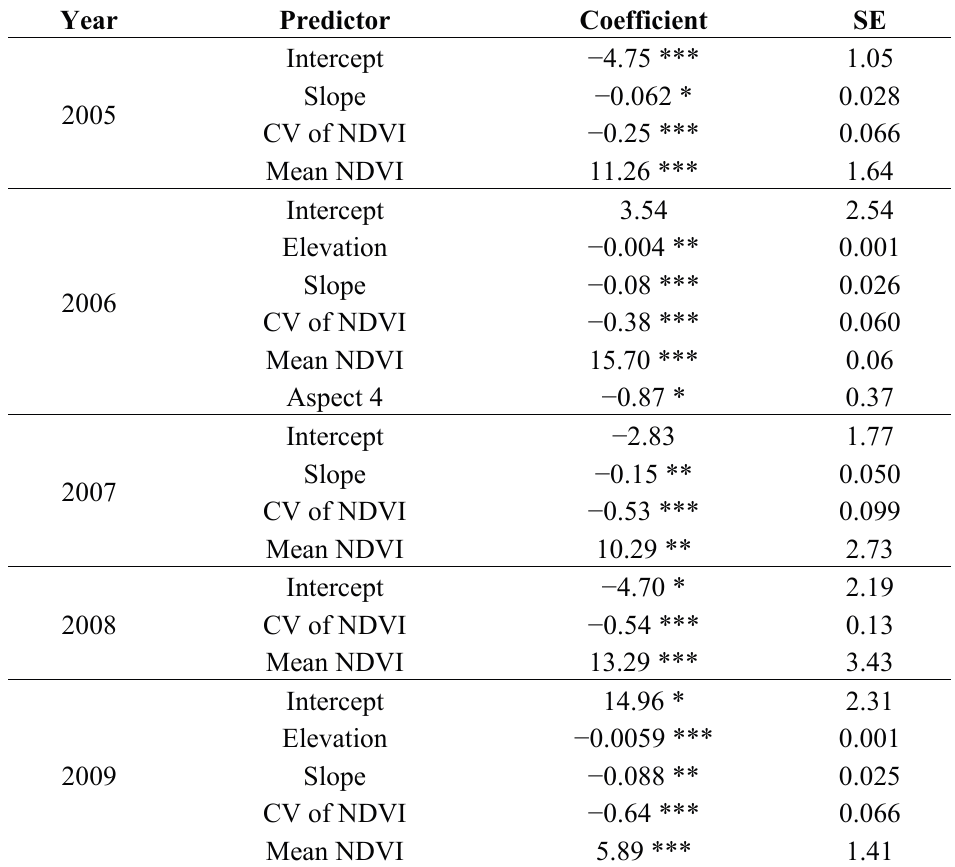
Table 3. Results of the logistic regression modeling of the annual monsoon/post-monsoon timing of peak NDVI for 800 random point locations across the ponderosa pine